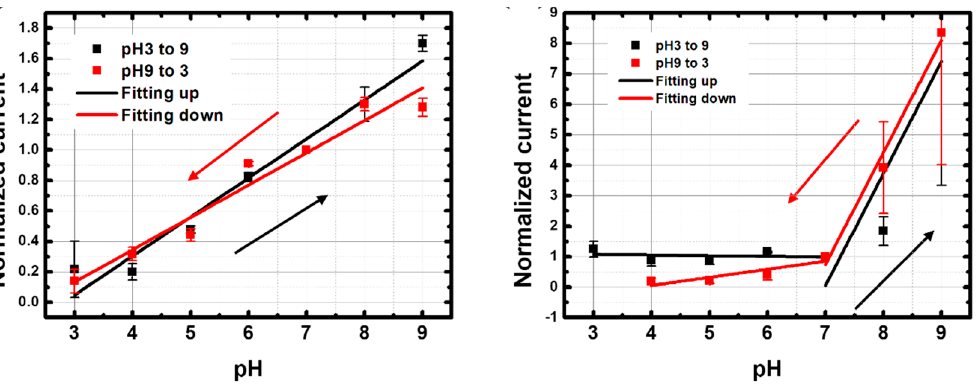
Figure 8. Normalized current values as a function of pH and linear fitting lines of ( left ) p-CNTFET and ( right ) f-CNTFET in phosphate buffer solutions (PBS) with increasing and decreasing pH from pH 3 to pH 9.